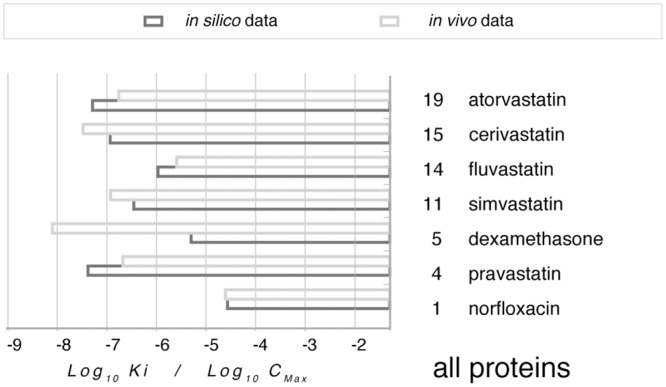
The highest affinity evaluated with any of the test calycins (Fig 9) is reported for each of the test drugs in systemic use in comparison with experimental Cmax.Data from http://www.rxlist.com/script/main/hp.asp and [45].